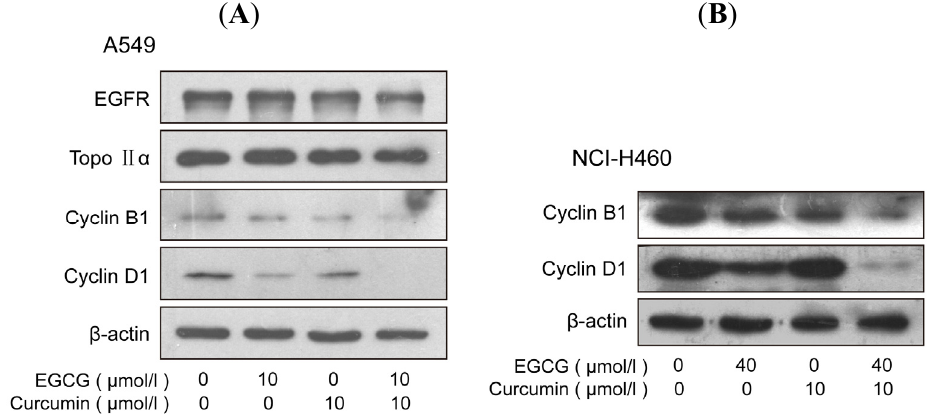
Figure 4. EGCG and curcumin significantly inhibited the expression of cell cycle related protein cyclin D1 and cyclin B1 in NSCLC cells. ( A ) Effect of EGCG and curcumin on cell cycle related proteins in A549 cells; ( B ) Effect of EGCG and curcumin on cell cycle related proteins in NCI-H460 cells. The cells were given indicated treatment for 24